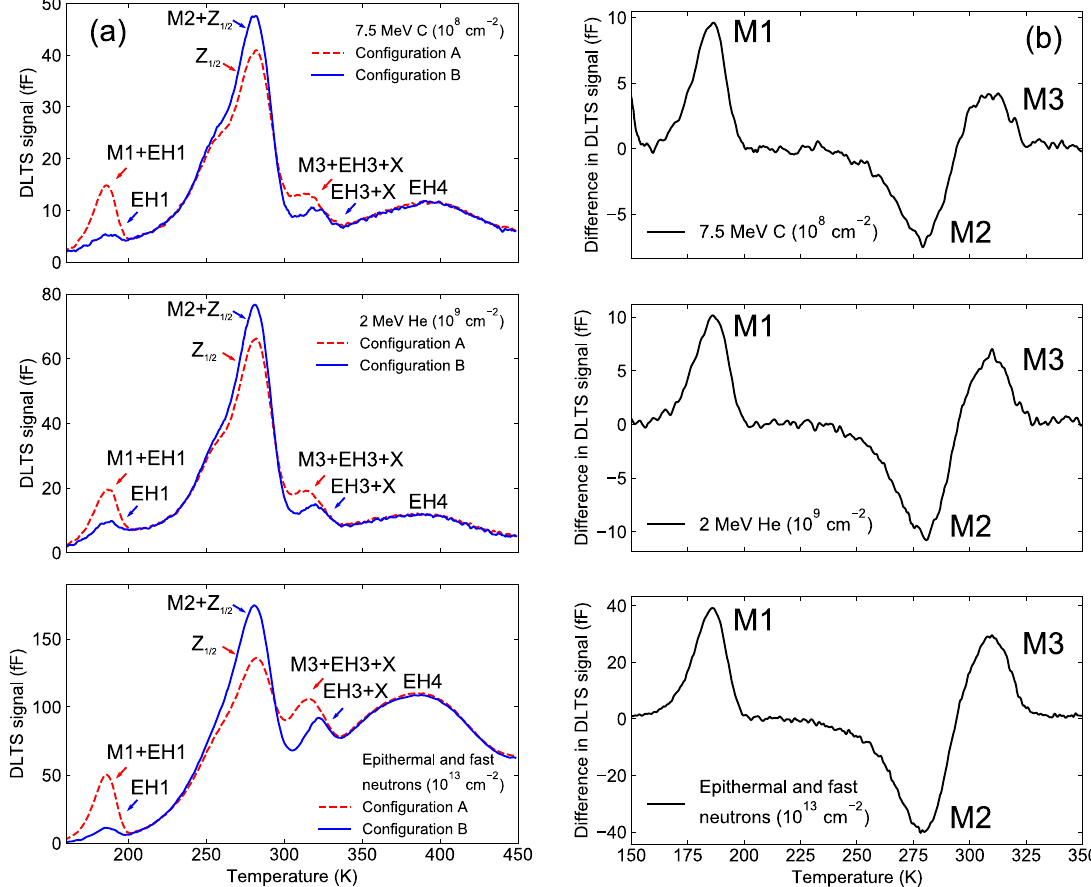
Figure 8. ( a ) DLTS spectra of C (10 8 cm − 2 ) and He (10 9 cm − 2 ) ion implanted, and neutron irradiated SBD in the temperature range up to 450 K with A and B configuration of the M-center. DLTS spectrum with configuration B is measured after cooling down the SBD from 450 K without bias, while configuration A is realized by cooling down the SBD from above room temperature (340 K) with applied bias − 30 V. The reverse bias V R = − 3 V is used in case of ion implanted SBD, while V R = − 10 V is used in case of neutron irradiated SBD. The pulse bias and pulse width V P = − 0.1 V and t P = 10 ms, respectively. The emission rate is 2.5 1 / s. ( b ) Di ff erence between two DLTS spectra with the M-center in configuration A and configuration B (shown in ( a )). The x-axis is shared between the vertically stacked graphs. As previously mentioned, the depth profiling measurements (Figure 6) indicate that an interstitially related deep level defect contributes to the DLTS signal at the temperature of the EH3 deep